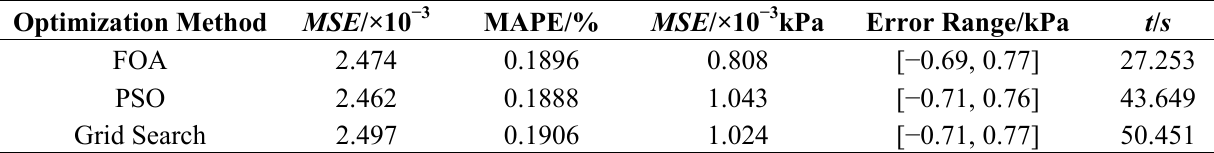
Table 4. Prediction performances using FOA, PSO and grid